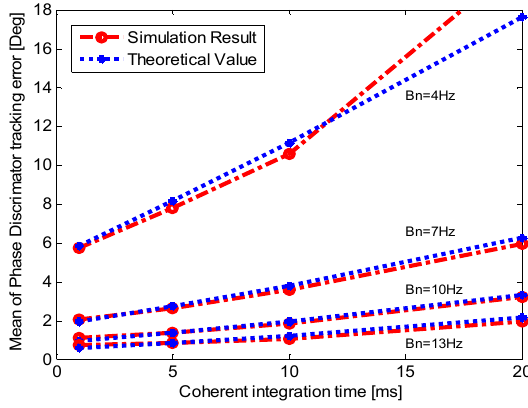
Figure 8. Mean of the output of PD when p = 200 m/s 3 .